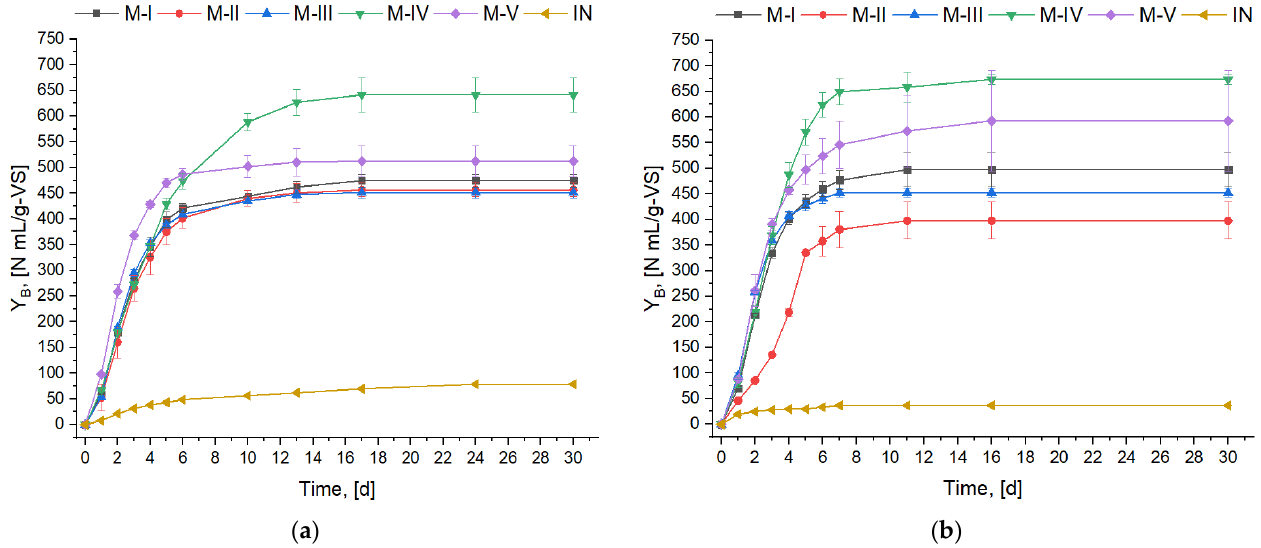
Figure 4. Cumulative specific biogas yield: ( a ) mesophilic temperature; ( b ) thermophilic temperature.